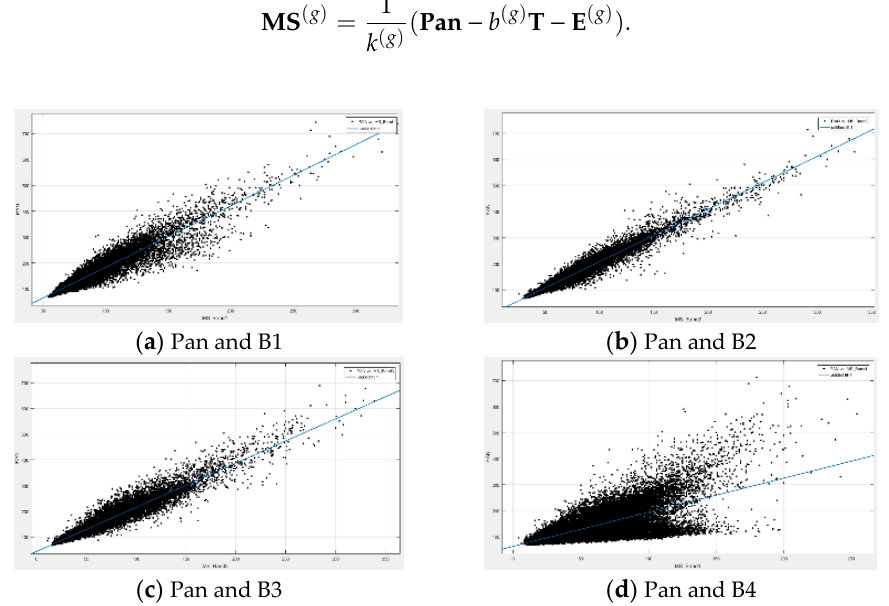
Figure 1. Digital number (DN) relationships between the panchromatic band and the different multi-spectral bands, where (a), (b), (c), and (d) are the distribution of the panchromatic band and multi-spectral bands 1–4, respectively.